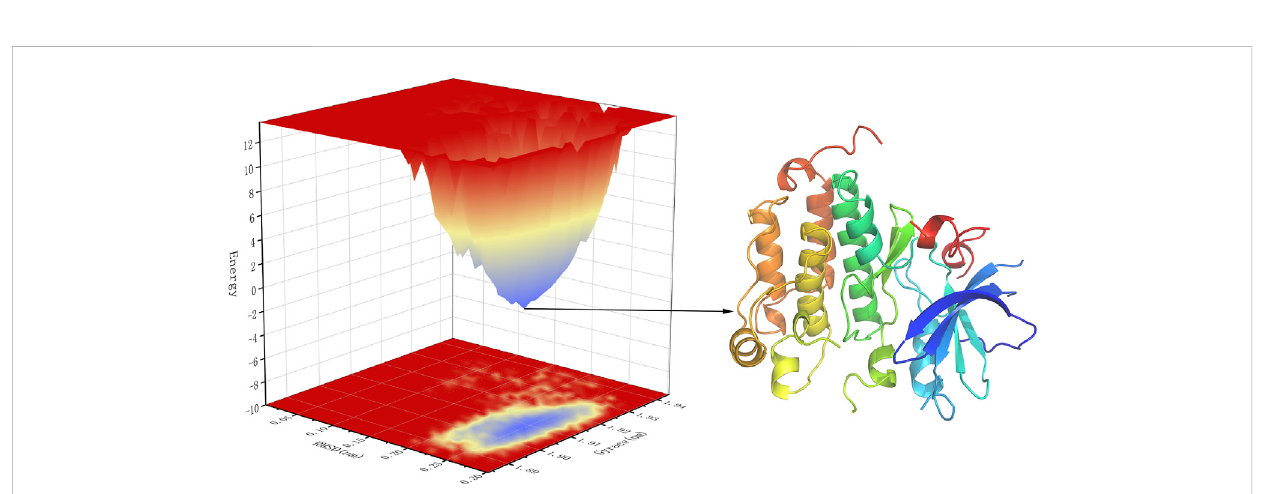
FIGURE 10 3D representation of binding free energy landscape as a function of RMSD and Gyrate. Energy distribution is shown by the coloring pattern: Blue de fi nes the conformational space with minimum energy (stable state) while red de fi nes a conformational space with maximum energy (unstable state). Transient local energy states are de fi ned by intermediate color